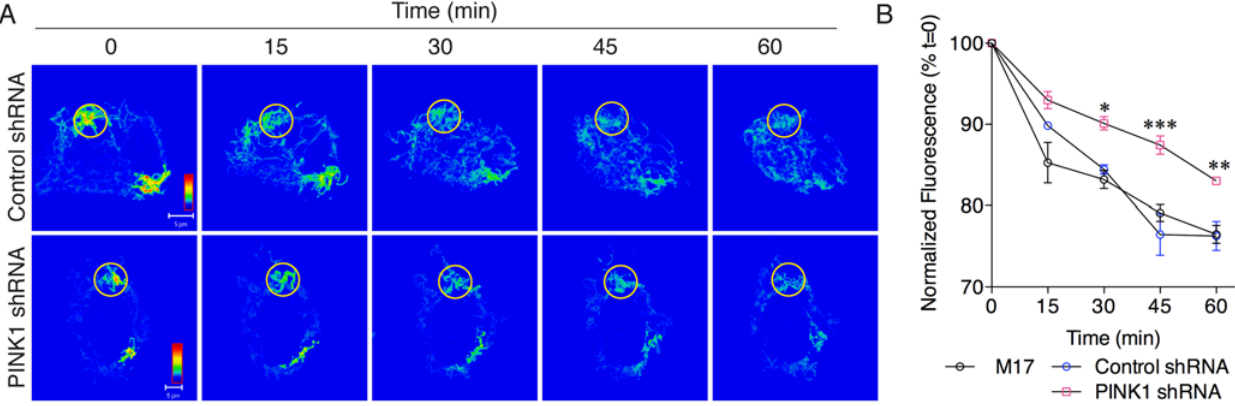
Figure 4. PINK1 deficient cells have fewer mitochondrial fusion events. (A) Control shRNA (upper panels) or PINK1 shRNA (lower panels) cells were transfected with a mitochondrially directed, photoactivatable GFP which was then photoactivated within a small region of interest (see Materials and Methods). Sequential images of the single cells (0, 15, 30, 45 and 60 minutes as indicated above the images) after photoactivation are shown. When cells are fusion-competent, decreases in fluorescence are seen over time in the region of photoactivation. Note that the fluorescence intensity is equal across the cell in the control line in the upper panel by 30 minutes, whereas the PINK1 deficient cell retains areas of higher intensity, indicating decreased fusion. Each scale bar is 5 m m and applies to all fluorescence micrograph in that series. (B) Quantification of experiments as in A (N=3 experiments, with n=9–10 cells measured per time point per experiment) shows the loss of fluorescence over time for parental M17 cells (black triangles), control shRNA (blue circles) or PINK1 shRNA (pink squares) cell lines. The difference between cell lines was significant by two-way ANOVA (P , 0.001), as was the effect of time (P , 0.001). Bonferonni post-hoc tests were used to compared PINK1shRNA lines to the control shRNA lines * P , 0.05; ** P , 0.01; *** P , 0.001. Error bars indicate the SEM between